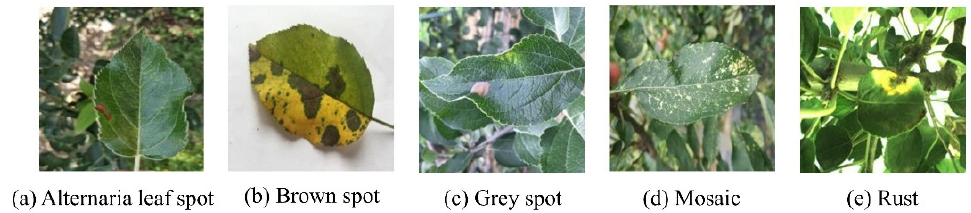
Figure 1. Examples of self-built apple leaf disease dataset in complex